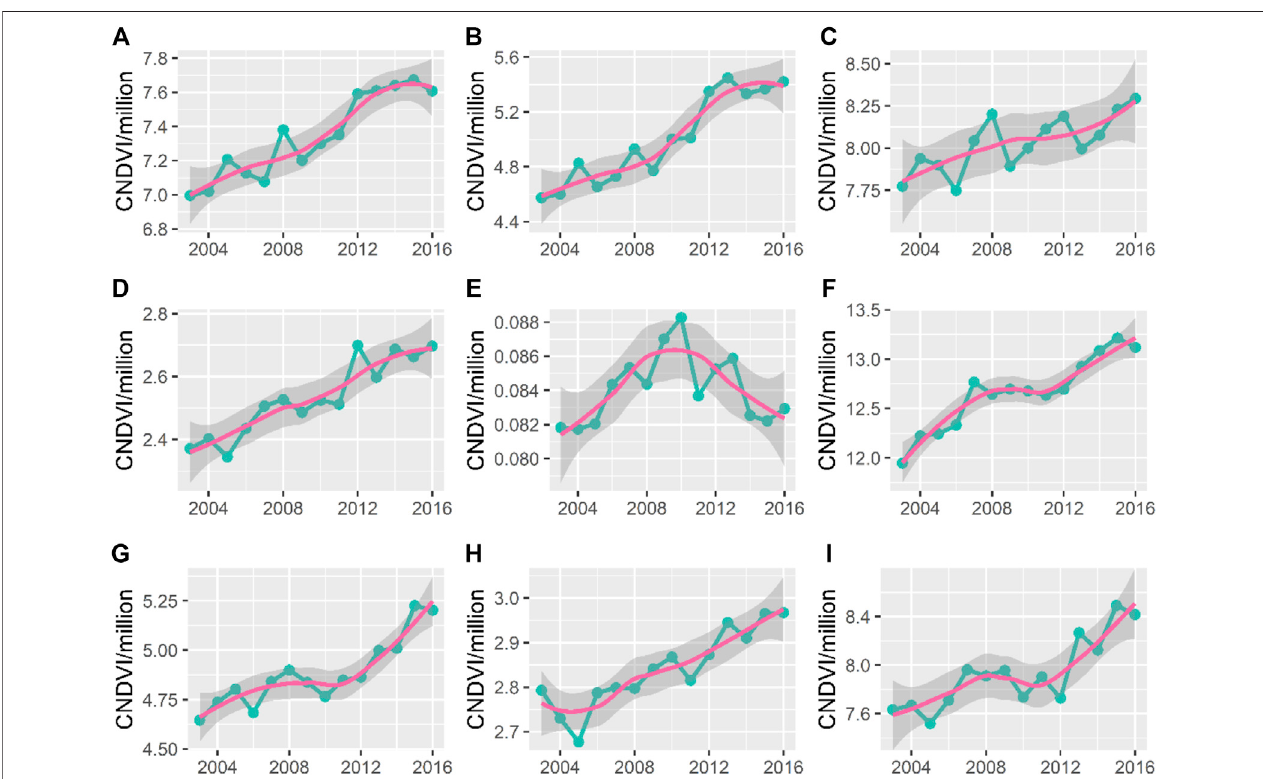
FIGURE 4 | Yearly CNDVI data Times Series plot with trendline from 2004 to 2016 in nine agricultural subdivisions of China in nine agricultural area [ (A) Northeast China Plain, (B) Northern arid and semi-arid region, (C) Huang-Huai-Hai Plain, (D) Loess Plateau, (E) Qinghai Tibet Plateau, (F) Middle-lower YangtzePlain, (G) Sichuan Basin and surrounding regions, (H) Southern China, (I) Yunnan-Guizhou